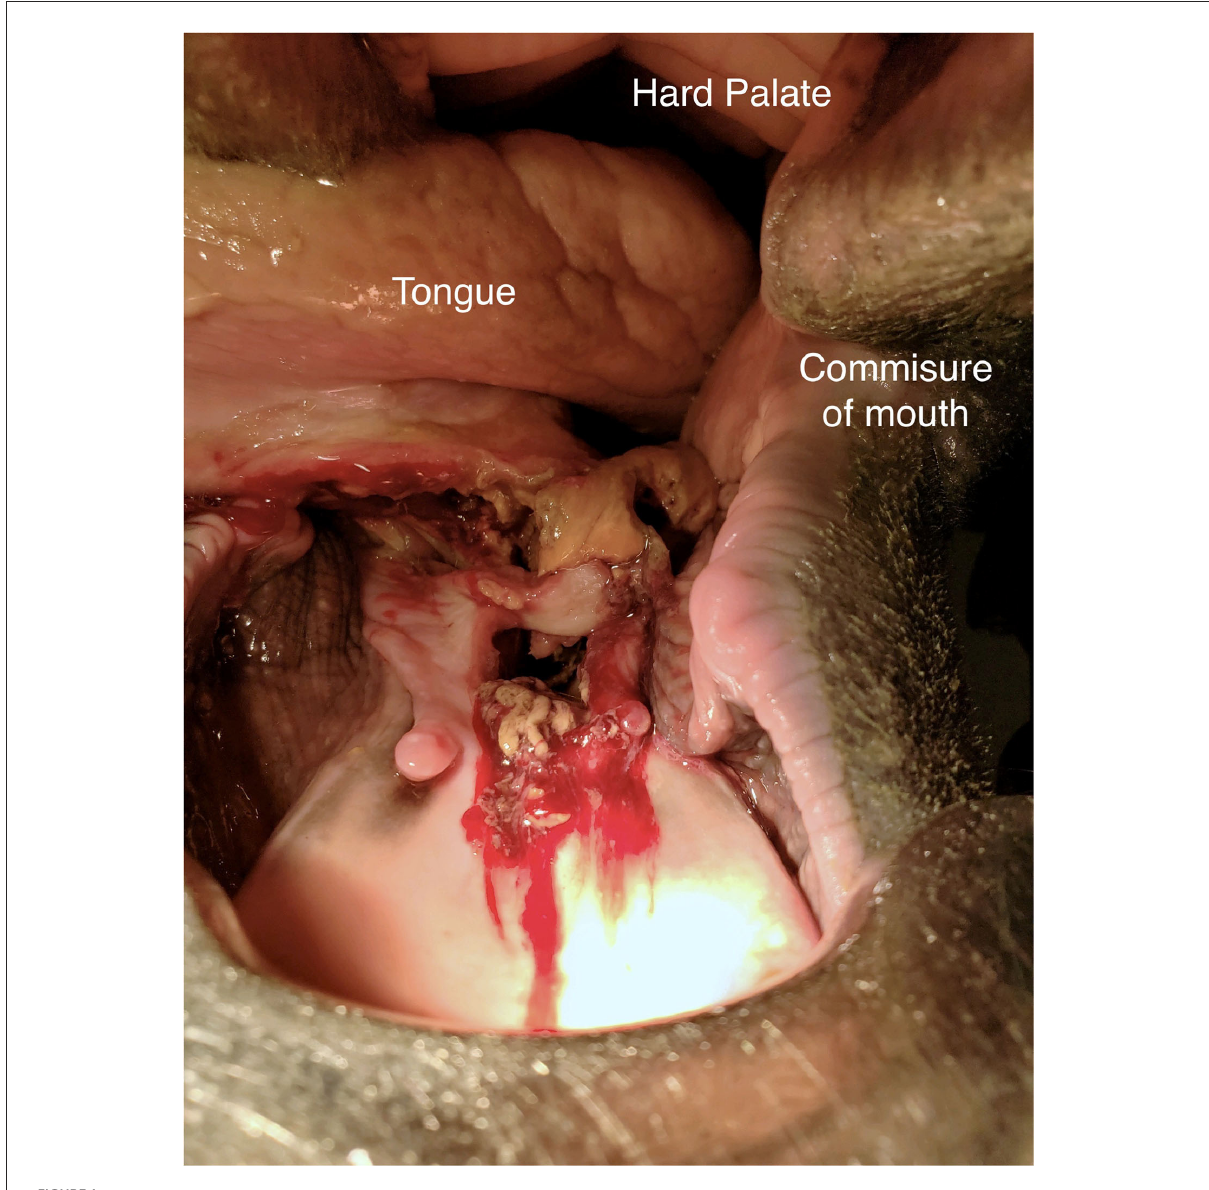
FIGURE1 Image of the intra-oral lesion on day 9 (treatment day 0) after initial presentation